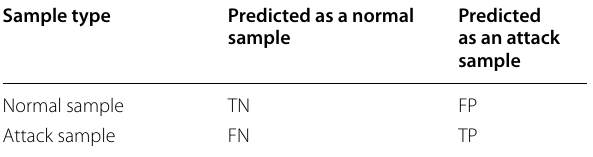
Table 1 Confusion matrix Sample